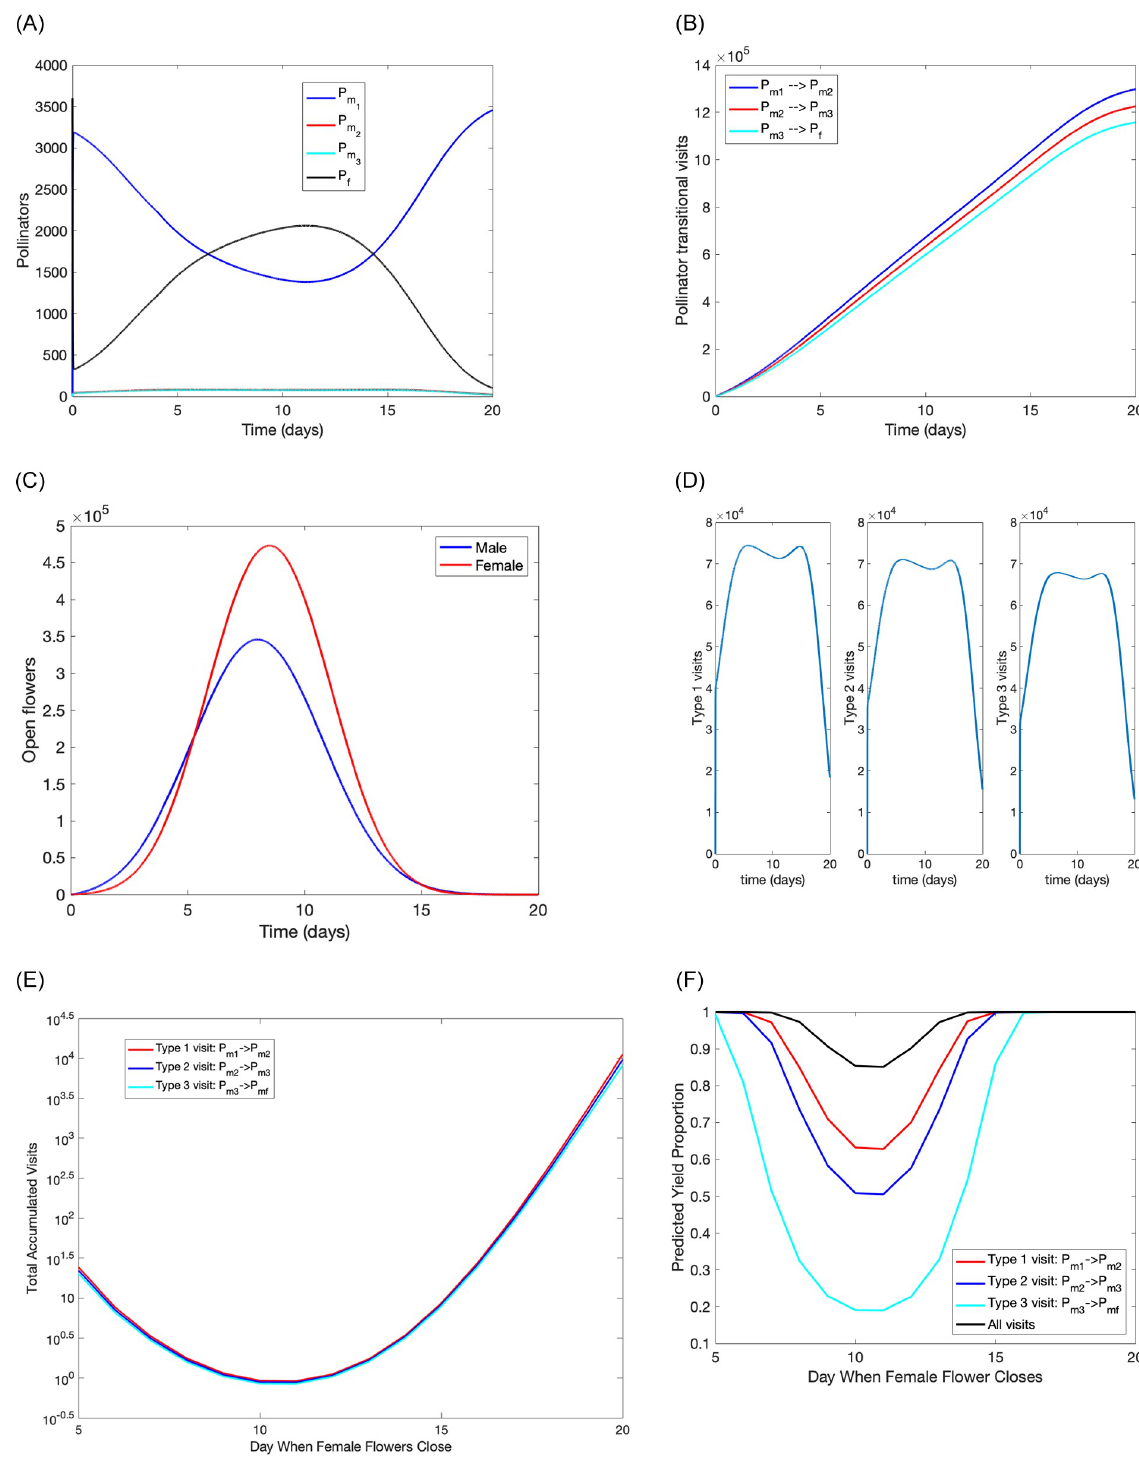
Fig 4. Model simulations presenting (a) number of pollinators during the bloom period, (b) accumulated number of transitional visits of different types, (c) number of open male and female flower during the bloom period, (d) daily number of transitional visits of different types, (e) daily number of transitional visits of different types per female flower at the time of closing, (f) predicted number of fully pollinated fruit for each type visit and all visits for female flowers at the time of closing. All parameter values are base values in Table 2 with initial conditions that pollinators haven’t collected any pollen yet ( i.e ., P